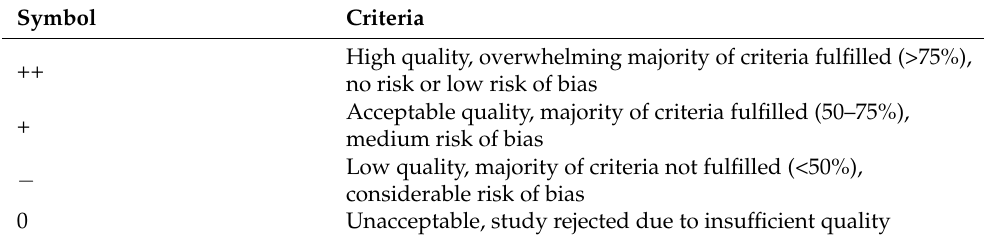
Table 2. Assessment of methodological quality according to SIGN checklists.